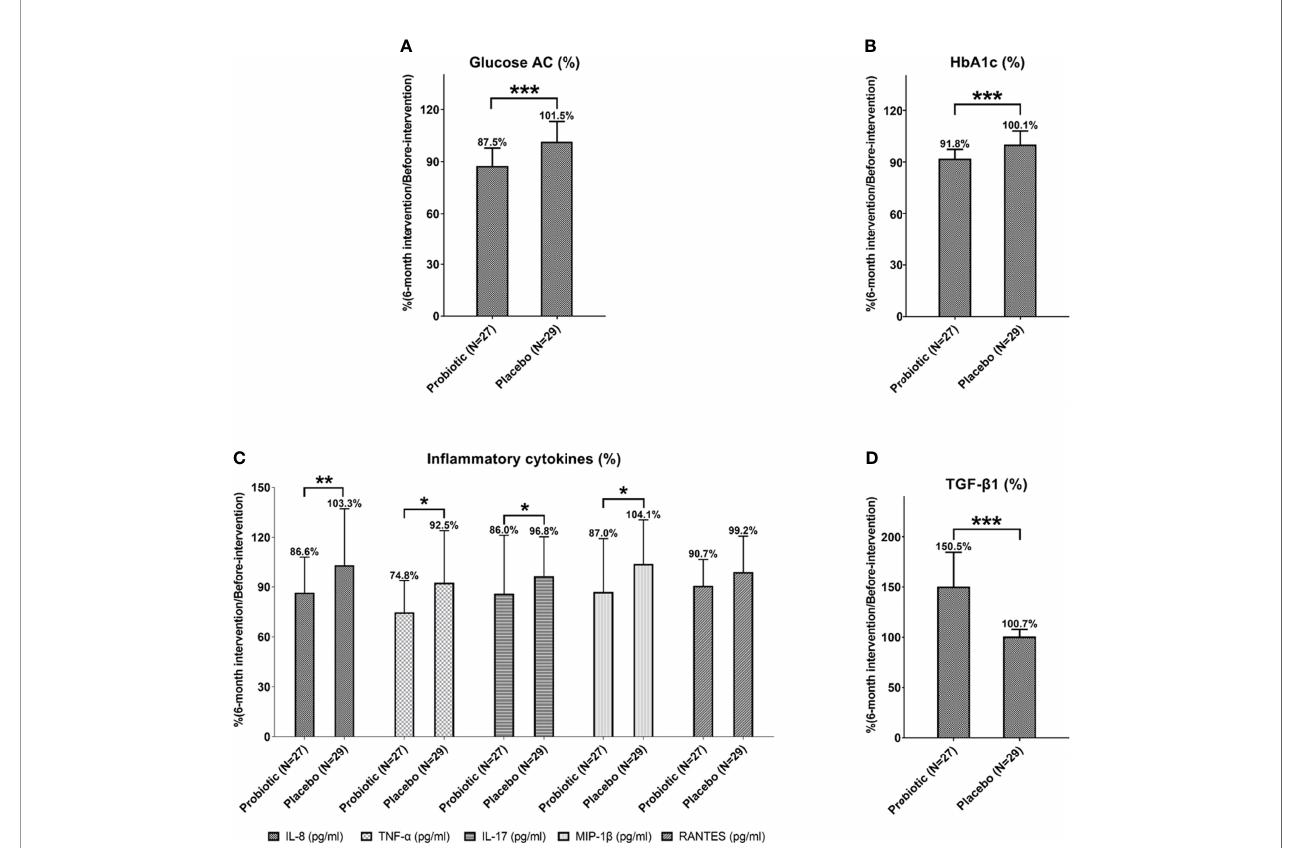
FIGURE 2 | The levels of Glucose AC (A) , HbA1c (B) , in fl ammatory cytokines (C) and anti-in fl ammatory cytokine TGF- b 1 (D) of patients with T1DM after 6-month probiotic intervention were normalized with before-intervention levels and then compared with the placebo group. Statistical differences between probiotic and placebo groups were shown as * P < 0.05, ** P < 0.01, and *** P < 0.001. Placebo group: T1DM patients receive regular insulin treatment but no additional probiotic supplementation. Probiotic group: T1DM patients receive regular insulin treatment with additional probiotic